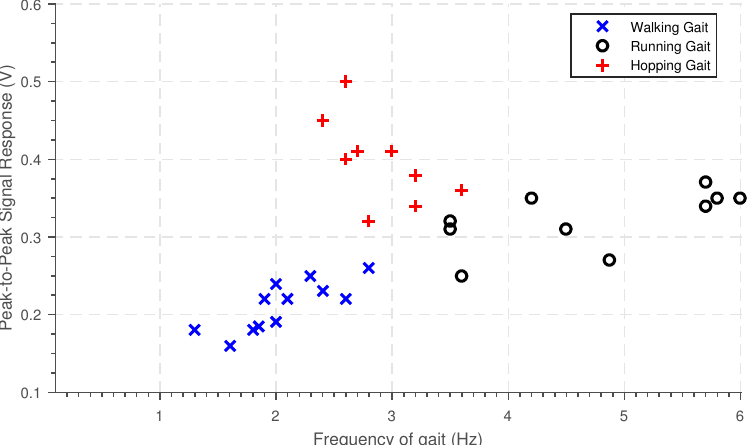
Figure 11. Figure showing the frequency of gait and the peak-to-peak magnitude of response determined from the calf sensors when undergoing various gait types.